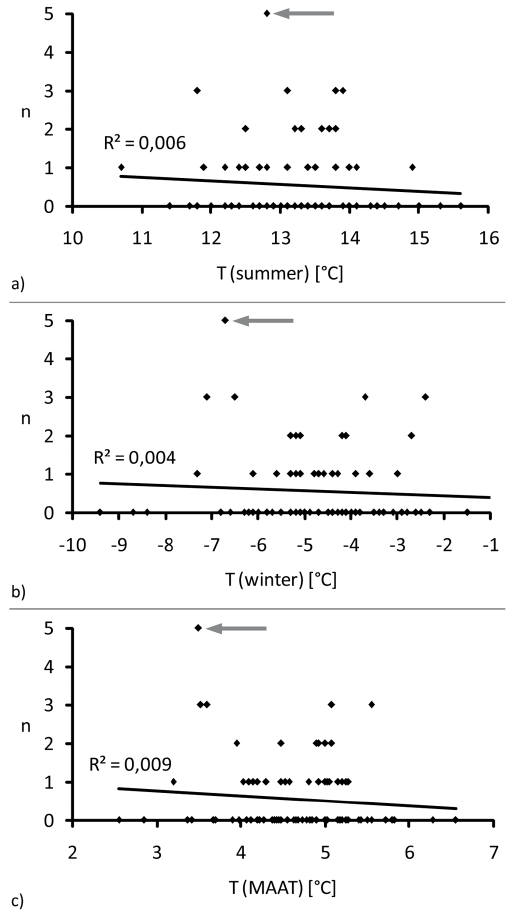
Fig. 4. (a–c) Correlation of the annual rockfall count (years 1900– 1995) with mean summer temperatures (June–August), mean winter temperatures (December–February) and mean annual temperatures. Arrows: year 1931 (see